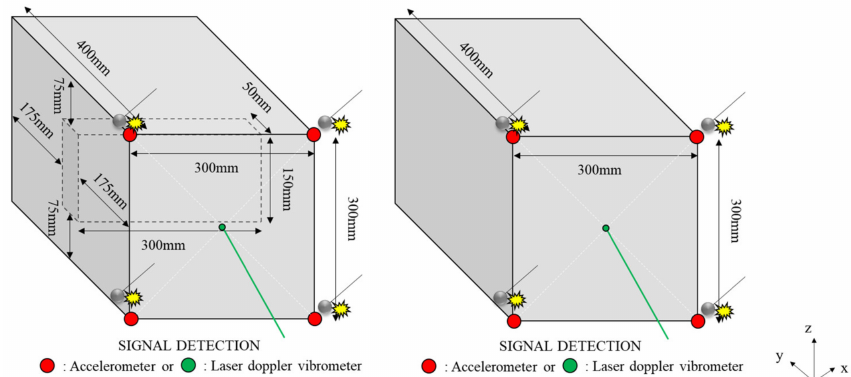
Figure 13. Concrete specimens and sensor locations (with defect and with no defect (intact)).